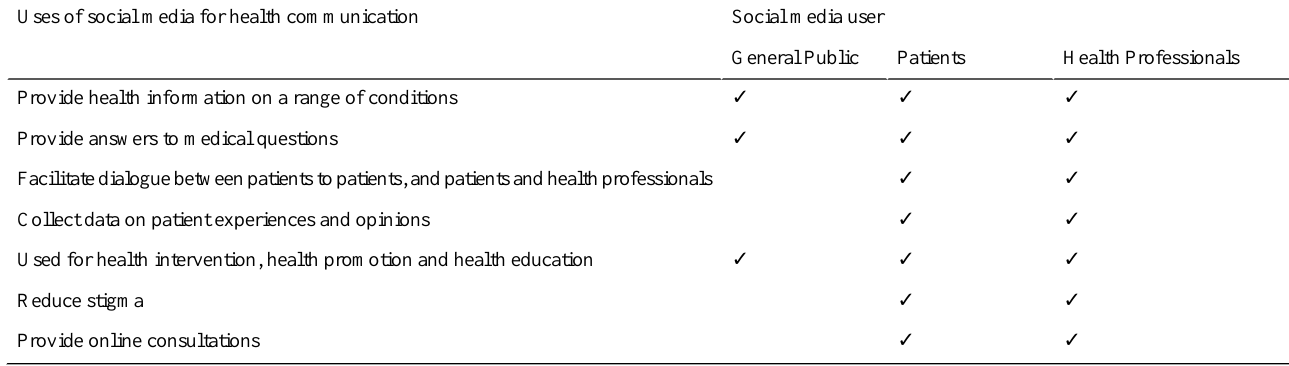
Table 3. Uses of social media for health communication among the general public, patients, and health